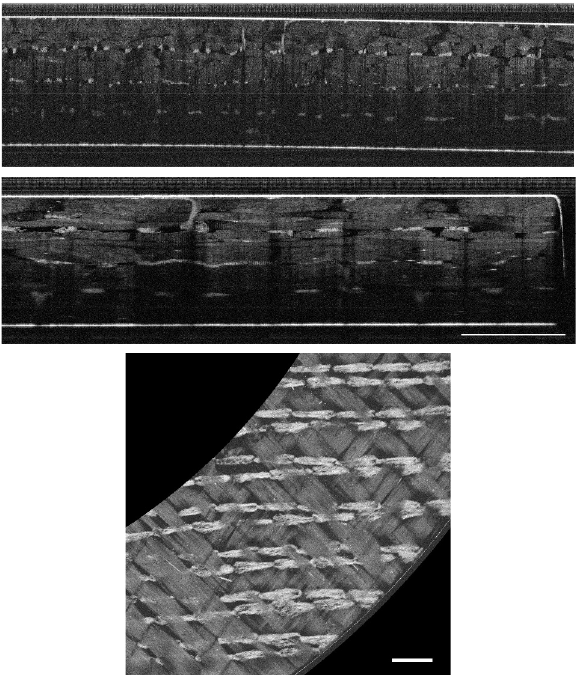
Fig. 1. OCT images of the rotating disc captured at 1200 rpm. Top: Azimuthal B-scan, the width corresponds to a length of 115 mm while the height is only 8 mm in air. Middle: Cross section in radial direction. Bottom: enface image at approx.